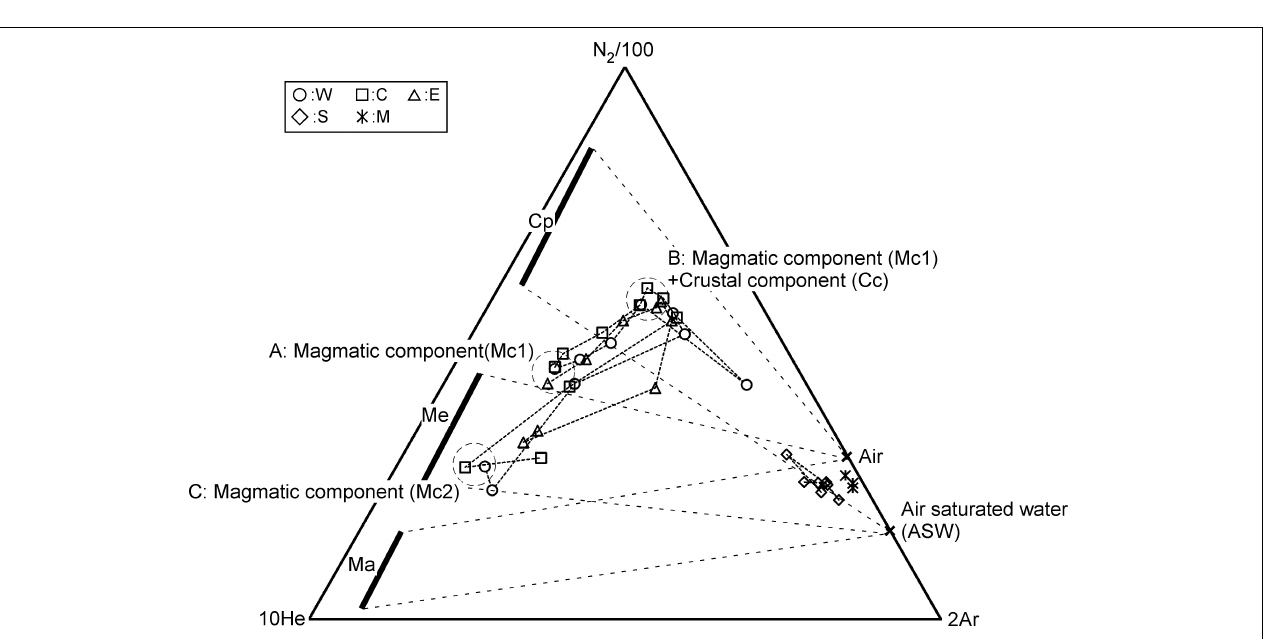
FIGURE 8 | He-N 2 -CH 4 ternary molar composition of fumarolic gas. The position of A, B, and C indicate the composition in July 2014, November 2017 and August 2018, respectively.